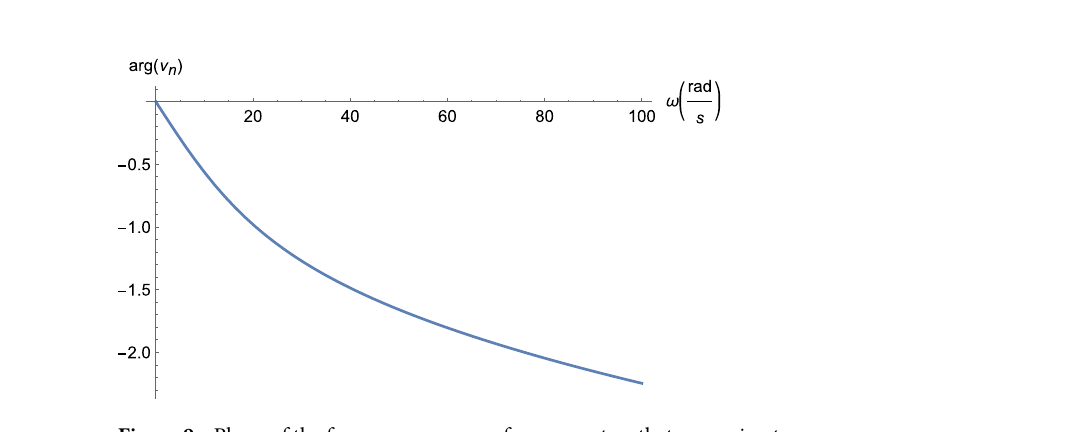
Figure 9. Phase of the frequency response for parameters that approximate an axon ( α = 10 − 6 , R = 10 12 � , C = 10 − 8 F , and | ν 0 | = 100 mV